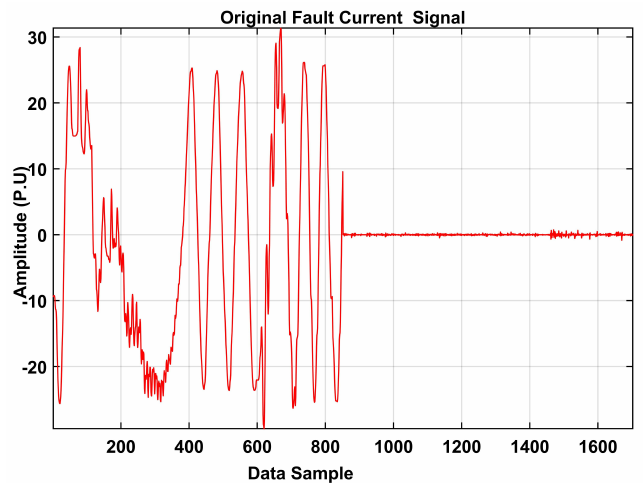
Figure 9. Fault Current with Noise Signal.